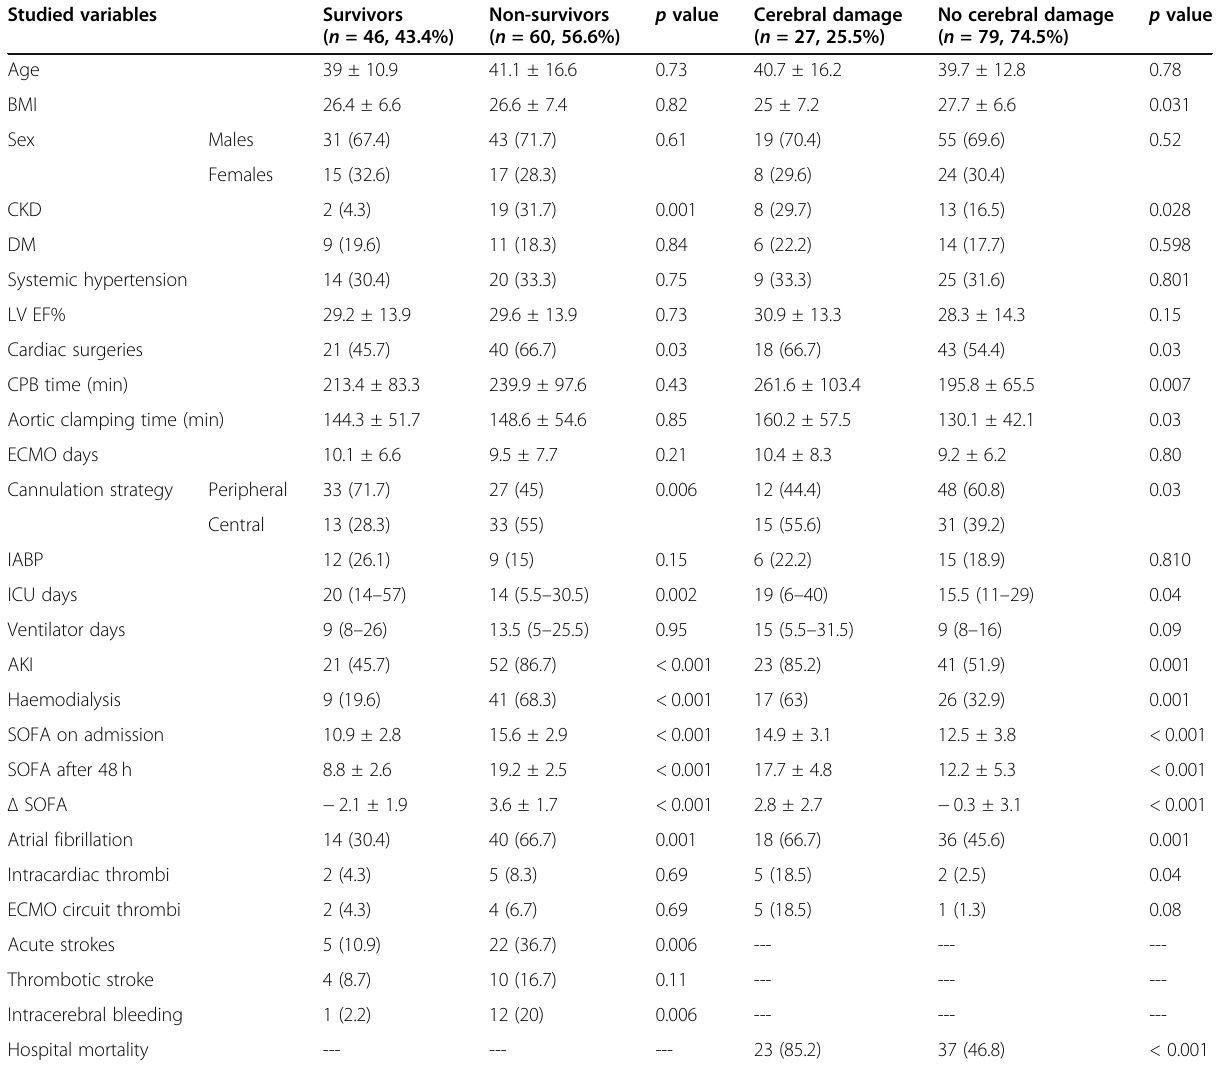
Table 1 Baseline and clinical data of studied VA-ECMO-treated patients Studied variables Survivors ( n = 46,